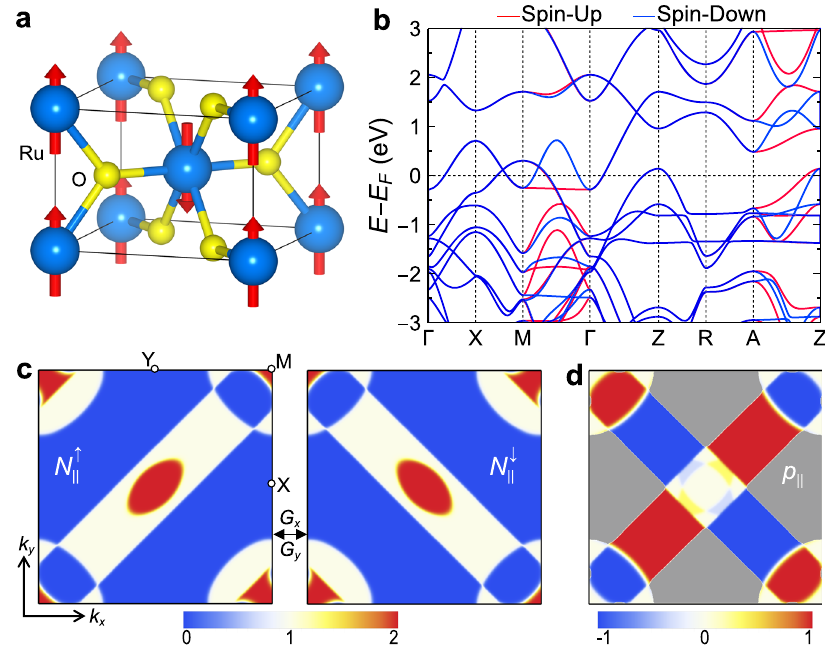
Fig. 2 Electronic properties of RuO 2 . a The atomic and magnetic structures of RuO 2 . b The calculated band structure of RuO 2 . c The number of ~ k k -resolved conduction channels in the 2D Brillouin zone of RuO 2 for spin up N " be transformed to each other by the glide transformations ^ G x or ^ G y . d Spin polarization of conduction channels p k ~ k k where N " ¼ N # ¼ 0 and thus p k unde fi ned. k k